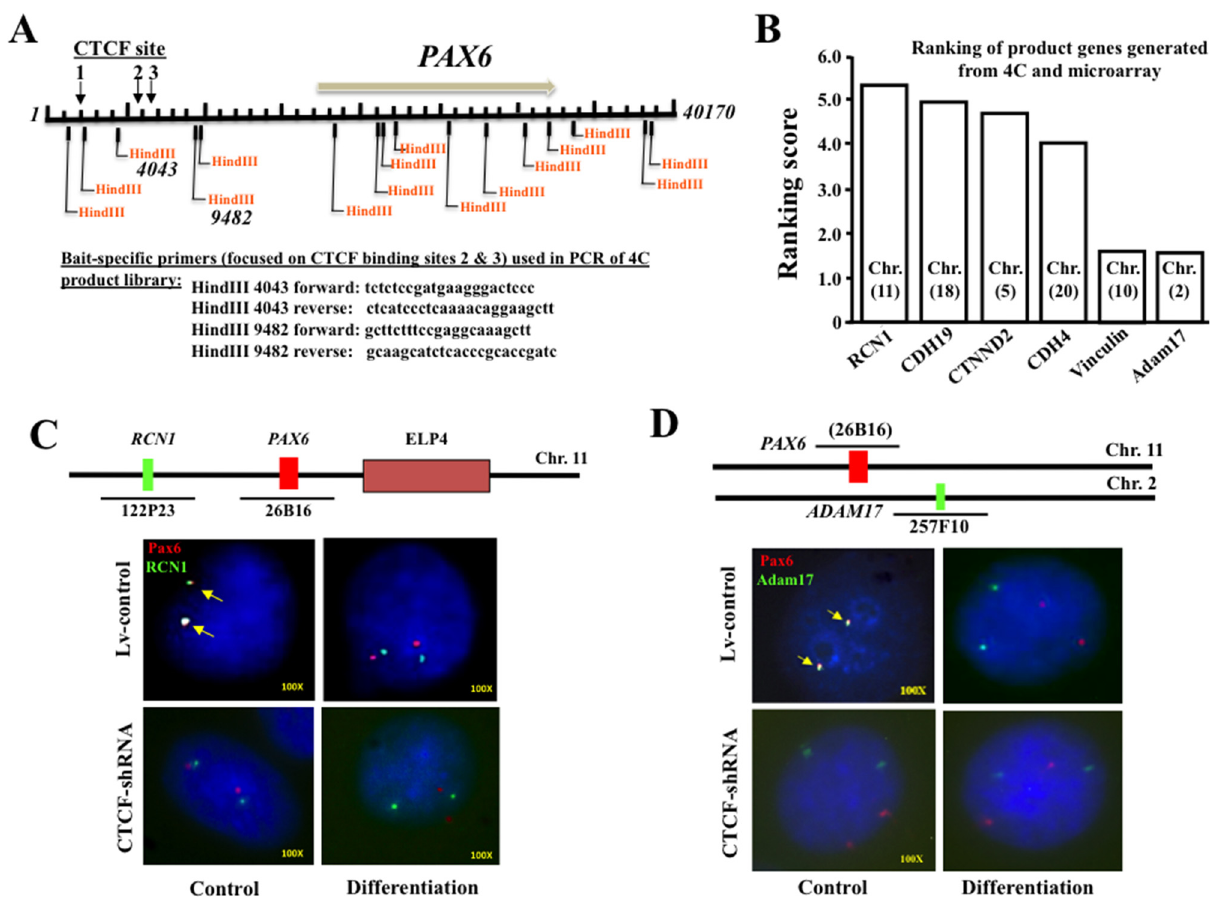
Fig 3. CTCF-mediated chromatin interactions of PAX6 with RCN1 and ADAM17 genes. ( A ) Illustration of circularized chromosome conformation capture (4C) primers designs relative to HindIII restriction sites which are adjacent to CTCF binding sites 2 and 3 on PAX6 promoter. ( B ) Six product genes were listed as CTCF-mediated PAX6 interactive genes (score > 1.5) from analysis with 4C and microarray results. ( C ) Confirmation of 4C results by FISH to truly identify interaction in promoter regions of PAX6 and RCN1 genes in lentiviral infected control (Lv-control), and lentiviral CTCF-shRNA infected (CTCF-shRNA) and CTCF-knocked down HTCE cells. ( D ) Verification of 4C technology by FISH to truly identify interaction in promoter regions of PAX6 and ADAM17 genes in Lv-control and CTCF-shRNA cells. Details of 4C and use of microarray were discussed in materials and methods. FISH assays were performed as described in materials and methods to determine positions of PAX6 gene locus relative to both RCN1 and ADAM17 gene loci. The BAC clones RPCI-11-26B16 encompassing PAX6 gene was labeled with Red 5-ROX dUTP (Empire genomics). Other BACs RPCI-11-122P23 for RCN1 and RPCI-11- 257F10 for ADAM17 were labeled with Green 5-Fluorescein dUTP (Empire